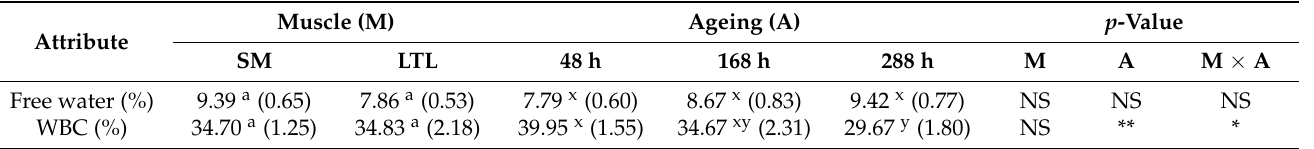
Figure 2. Water binding capacity in semimembranosus (SM) and longissimus thoracis et lumborum (LTL) muscles aged for 48 h, 168 h, and 288 h (a,b—mean values with different letters differ significantly at p < 0.05; vertical bars refer to the standard error of the mean).